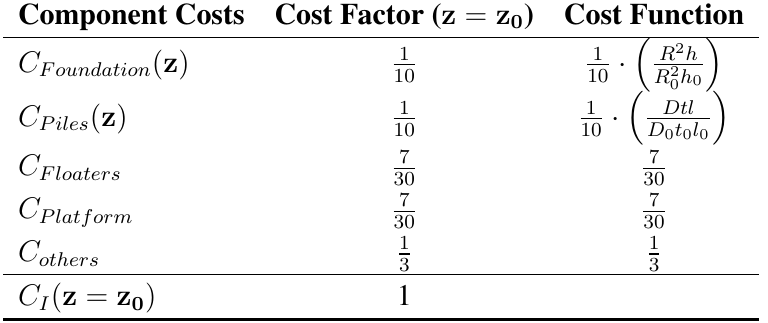
Table 3. The considered cost factors (portion of total investment costs when the reference device is built) and the cost function for dimension-dependent